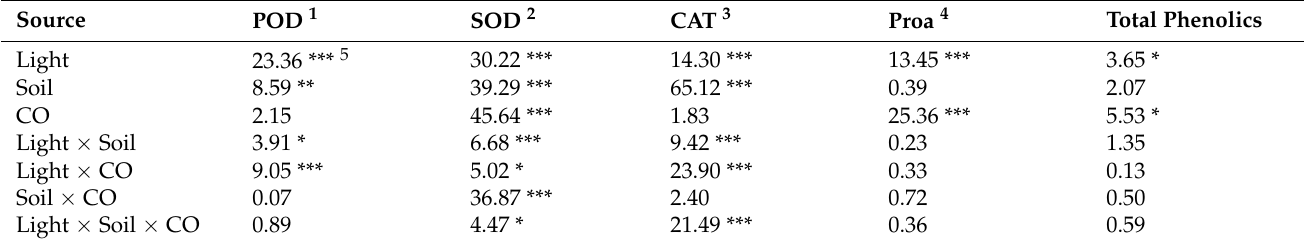
Table 5. F values from analysis of variance (ANOVA) of combined factors of lighting spectra (Light), soil amendment (Soil), and chitosan oligosaccharide (CO) addition on antioxidant enzymes’ activities in leaves and fruit quality of black chokeberry ( Aronia melanocarpa (Michx.) Elliott 1821) seedlings.